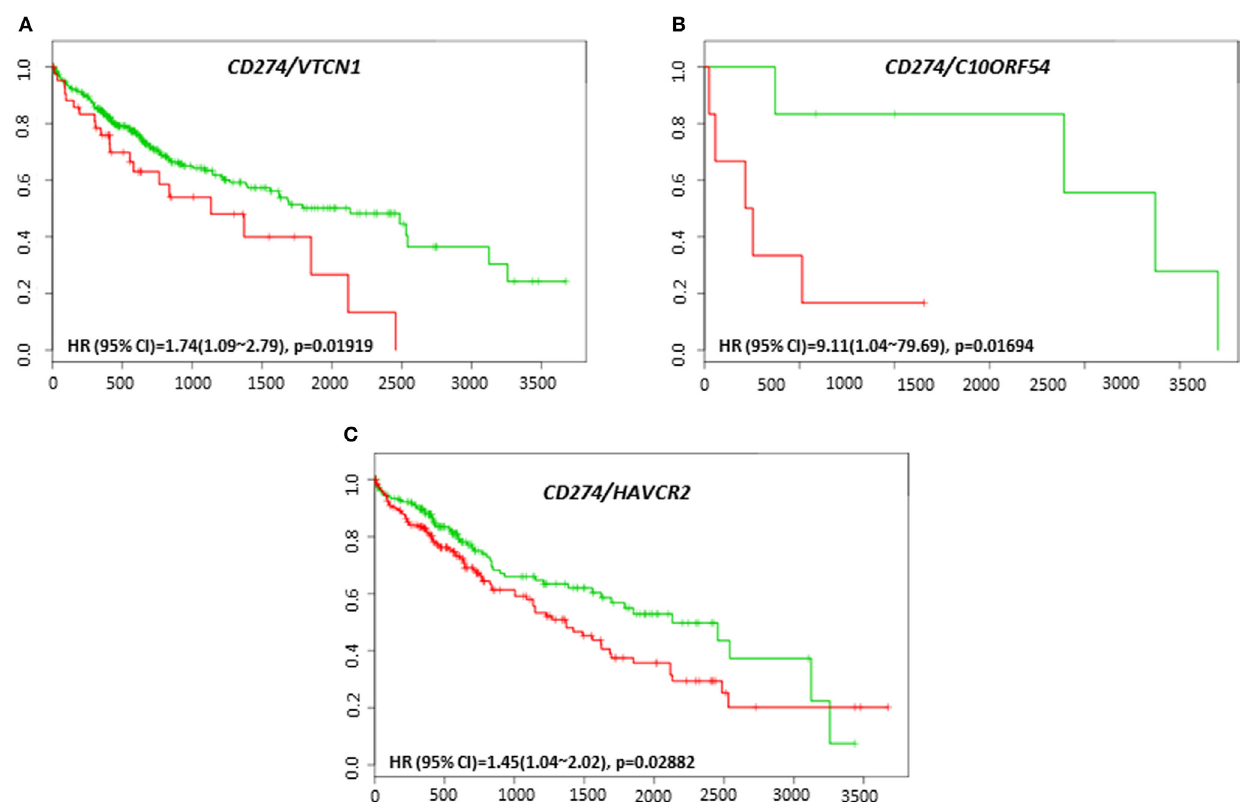
FigUre 5 | Relationship of immune modulators in combination with PD-L1 (CD274) and survival in HCC patients. Kaplan–Meier survival curves generated using the SurvExpress for the analysis of survival and gene expression of (a) CD274/VTCN1 , (B) CD274/C10ORF54 , and (c) CD274/HAVCR2 in HCC patient samples. Green curve represents low-risk group, while red curve represents high-risk group. The study time (months) is presented in the x -axis. The insert shows the hazard ratio, confidence interval, and Log-Rank Equal Curves p value. Markers ( + ) represent censoring